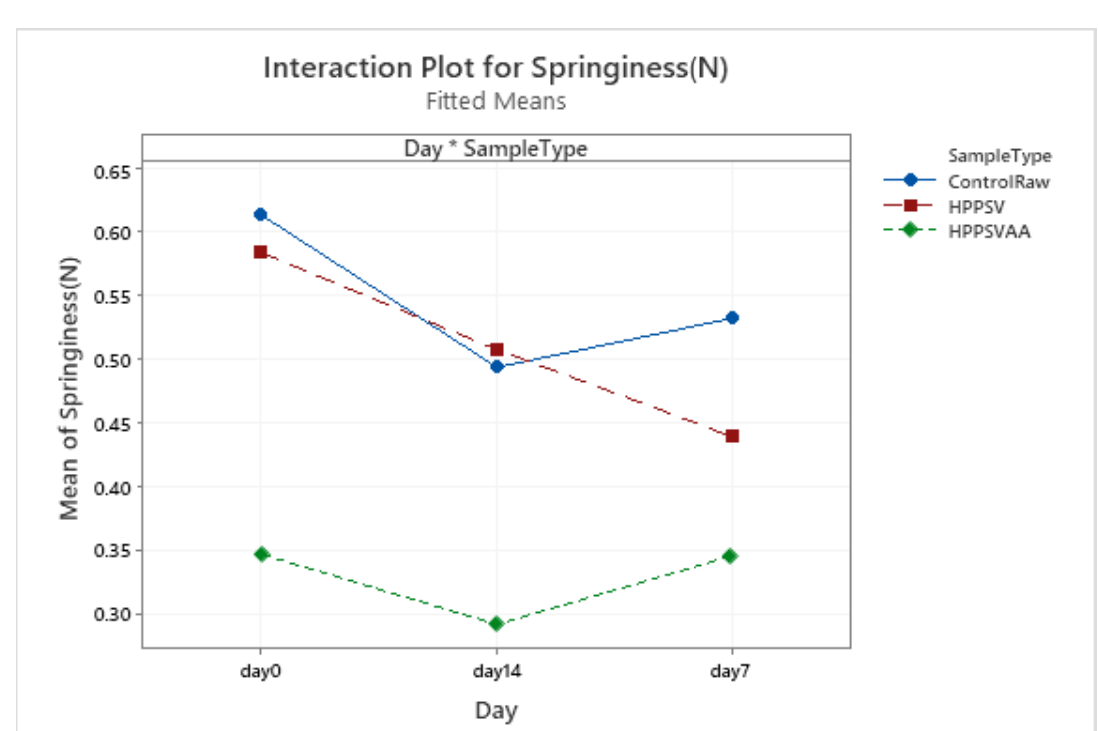
Figure A5 . Effect of treatments and storage time on the hardness of plant-based patty (HPPSV: HPP-SVCOOK).